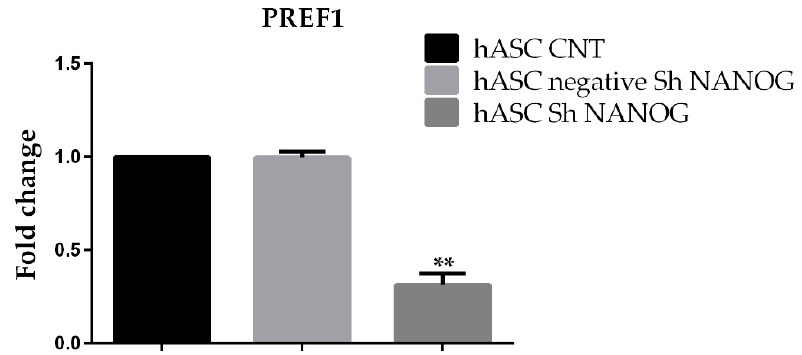
Figure 3. qRT-PCR analysis of PREF1 gene expression in freshly isolated hASCs at passage 4 (hASCs CNT), hASCs lentivirally transducted with scrambled (negative) and shRNA against NANOG (hASCs sh NANOG ). PREF1 was significantly downregulated in hASCs sh NANOG . Relative expression levels were assessed using the 2 − ∆∆ C t method. Data are representative of three independent experiments with the fold change compared to expression levels in a commercial human adipose stem cell line (ASC52telo, hTERT immortalized adipose-derived mesenchymal stem cell). The experiment was repeated at least three times ** p < 0.01.